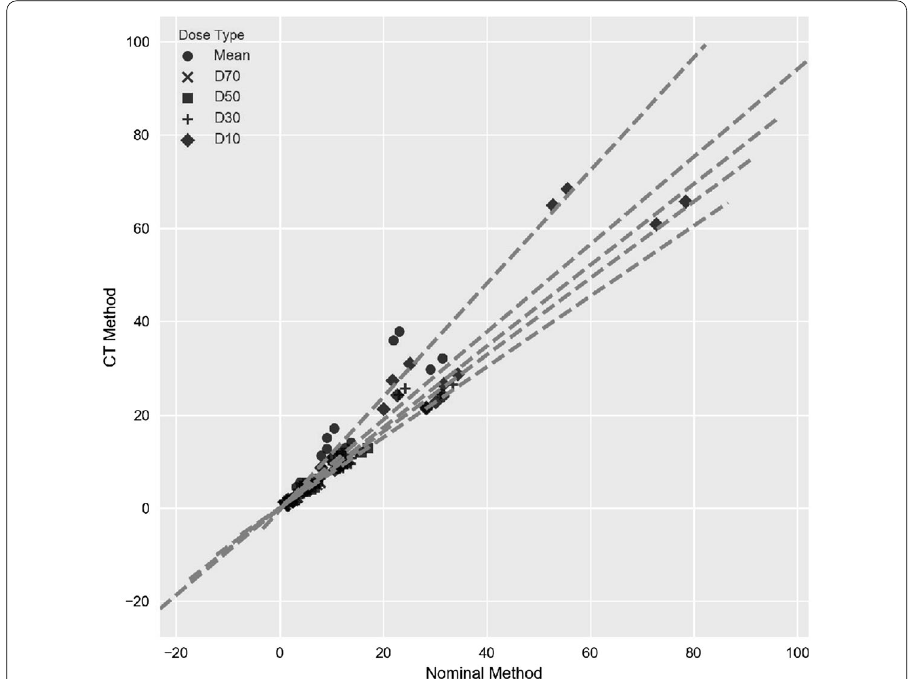
Fig. 4 The linear regressions represent weighted dose factors that compares the mass density differences between the CT and nominal local deposition methods for a particular dose metric, N = 20 . N represents the number of data points compared for each dose metric for the